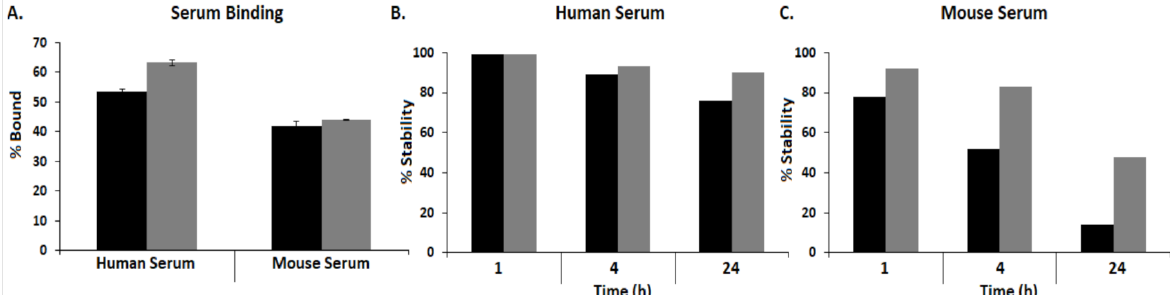
Figure 3. ( A ) Binding to human and mouse serum ( n = 3/compound/condition; bars: SD). ( B ) Stability in human serum at 37 °C. ( C ) Stability in mouse serum at 37 °C for [ 64 Cu] 1 ( ■ ) and [ 64 Cu] 2 ( ■